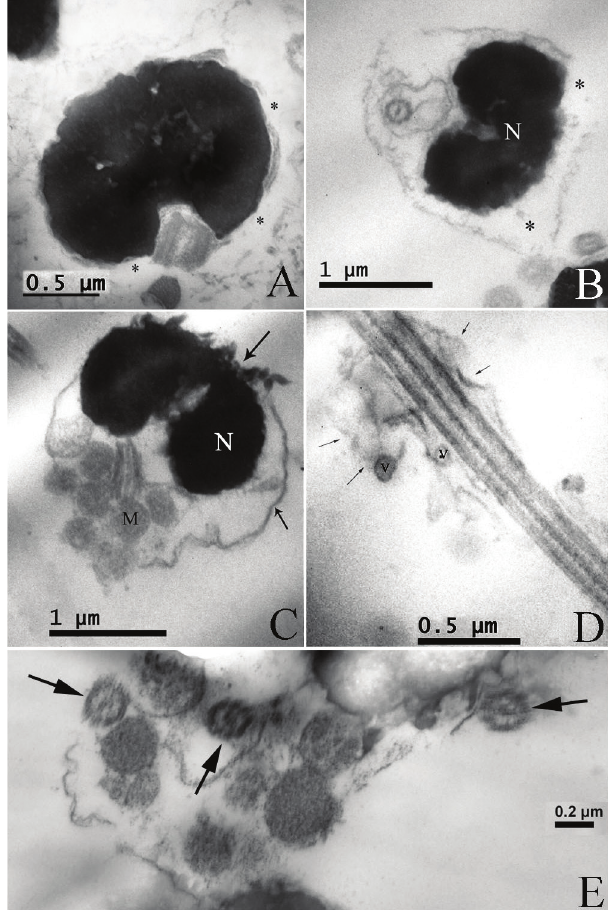
Fig. 4. Transmission electron microscopy photographs of pejerrey post thawed sperm showing different types of alter- ations. (A) Head with ruptured membranes (*). (B) Head with swollen and broken membrane (*). (C) Broken and swollen nuclear membrane (arrows) and alteration of the spatial orien- tation of mitochondria. (D) Ruptured and swollen membrane of the flagellum (arrows) with vesicles. (E) Tail around the head (arrows). N: Nucleus; M: Mitochondria; V: